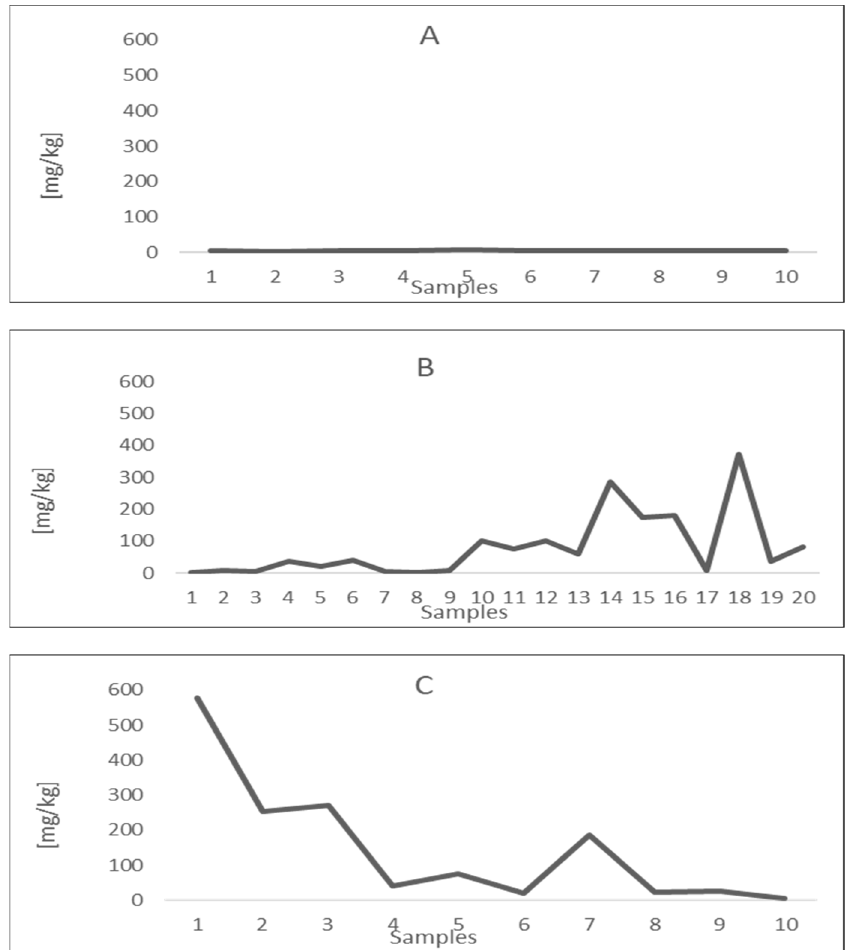
Figure 2. Pb concentrations in from all locations: ( A ) North, ( B ) Middle, and ( C ) South. The x-axis represents latitude in that samples progress from north to south with an increasing sample number at each location.